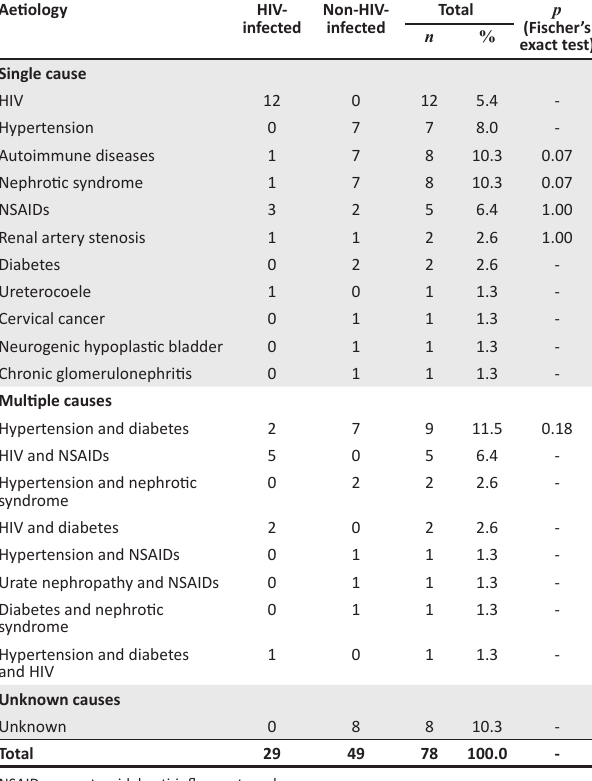
TABLE 1: Aetiology of end-stage kidney